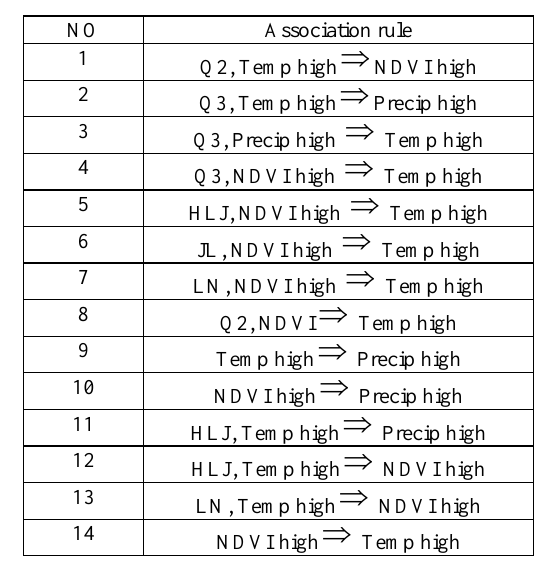
Table 4.The rules filtered by lift